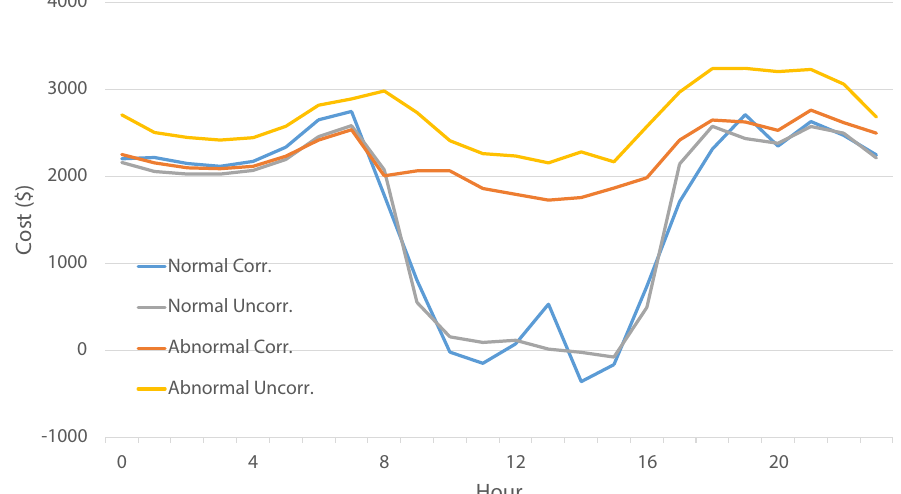
Figure 16. Winter normal − abnormal comparison (ratio = 0.6).